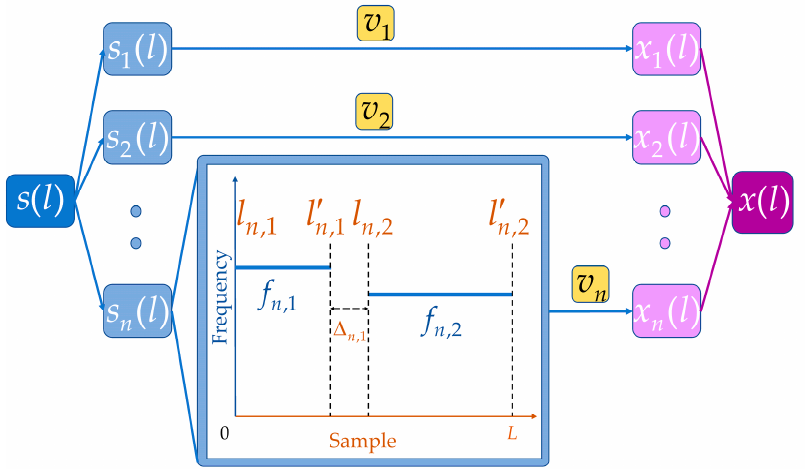
Figure 1. The enhanced two-hop model.